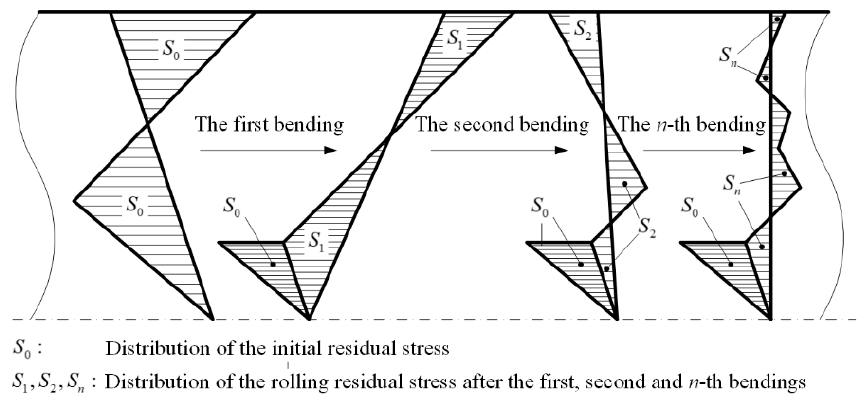
Figure 5. Evolution process of the residual stress in multi-roll levelling.